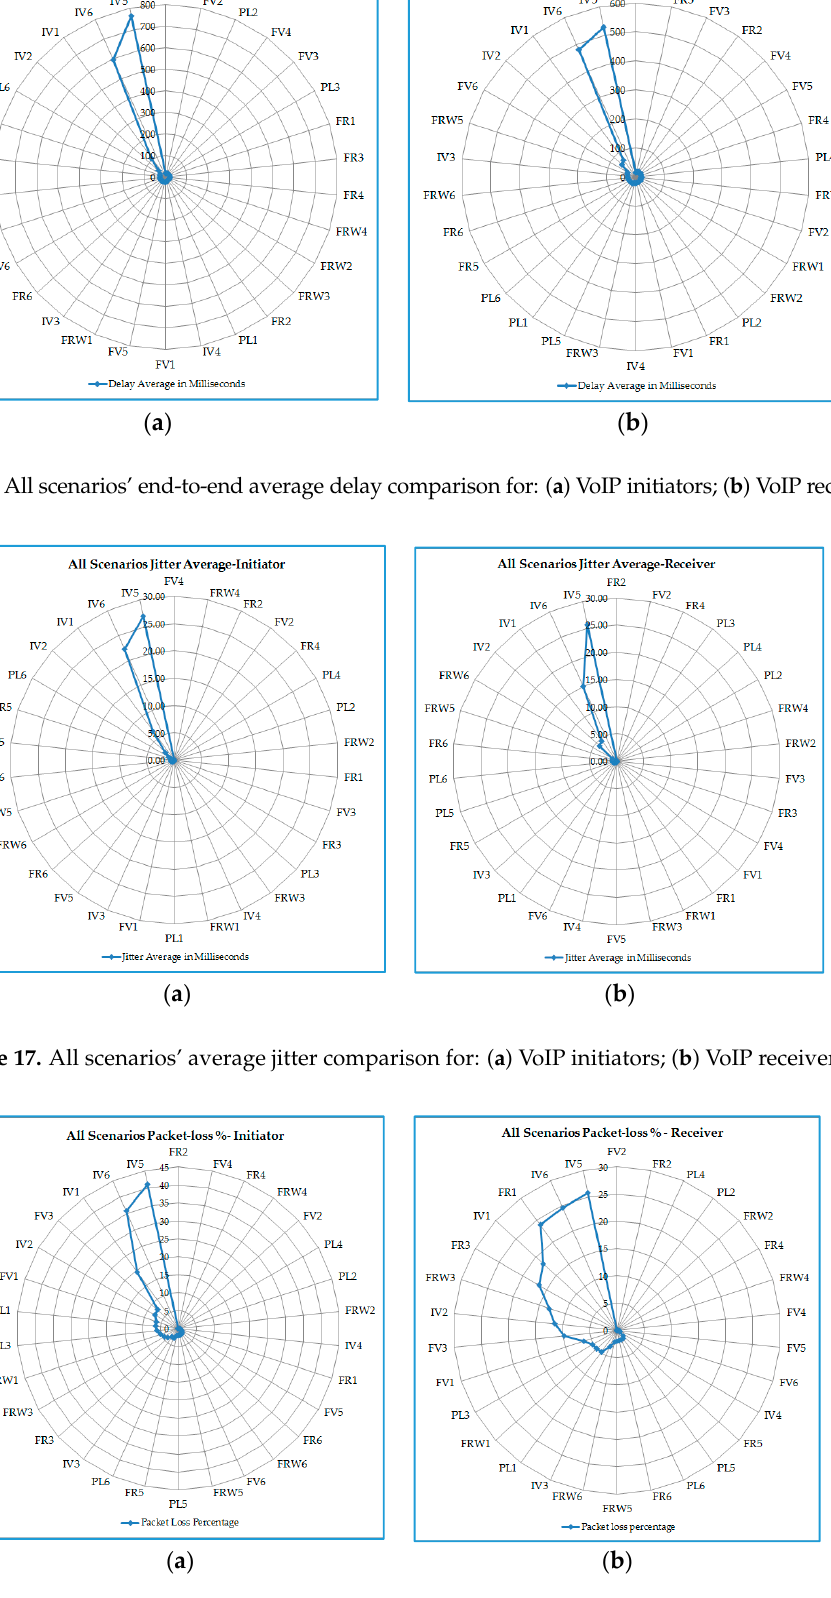
Figure 18. All scenarios’ packet-loss % comparison for: ( a ) VoIP initiators; ( b ) VoIP receivers. The MOS values for VoIP initiators and receivers are analyzed and compared in Figure 19.